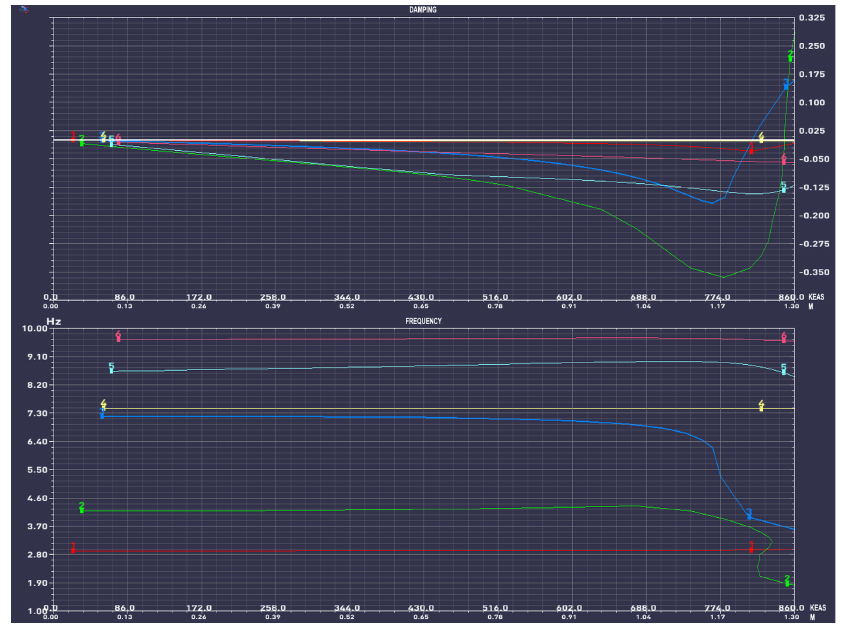
Figure A1. Typical V-G sample plot from VGPlotter. Notice the frequency variation in Modes 2 and 3 and the change from negative to positive damping factor (flutter point) in the vicinity of the airspeeds where those two frequencies get close